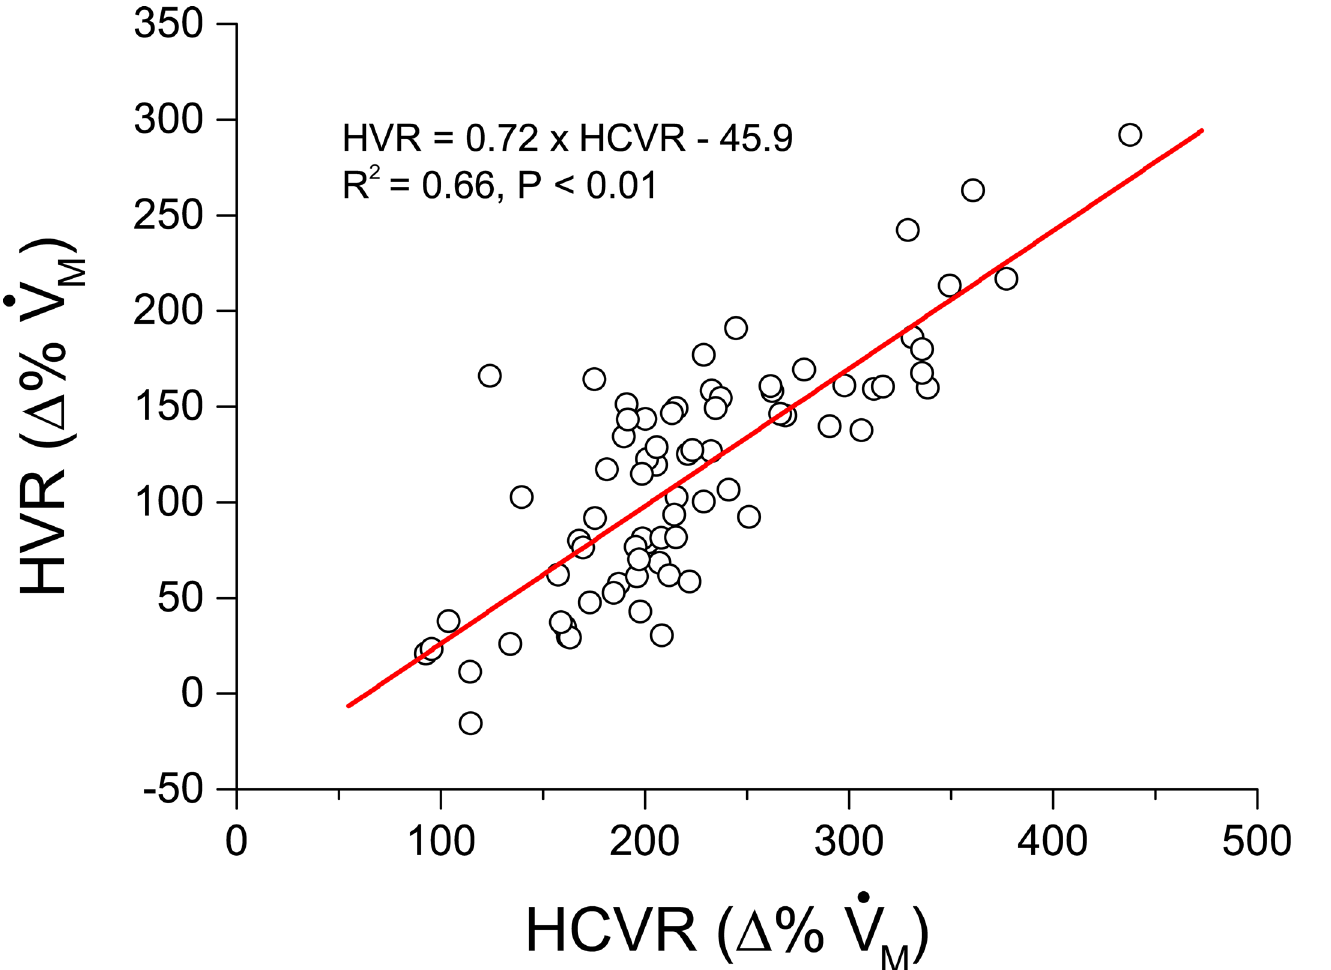
(cid:1) Fig 5. Correlation of HVR and HCVR values ( V M ) in HK483 mice. The values of HRV measured at -2, -1, 1, 2, and 3 days after intranasal inoculation were plotted against those of HCVR at the same times. n = 15 HK483 mice for each day (total 5 days, 75 data points). The signi fi cant correlation suggests that a poor HVR is often associated with an inadequate HCVR in HK483